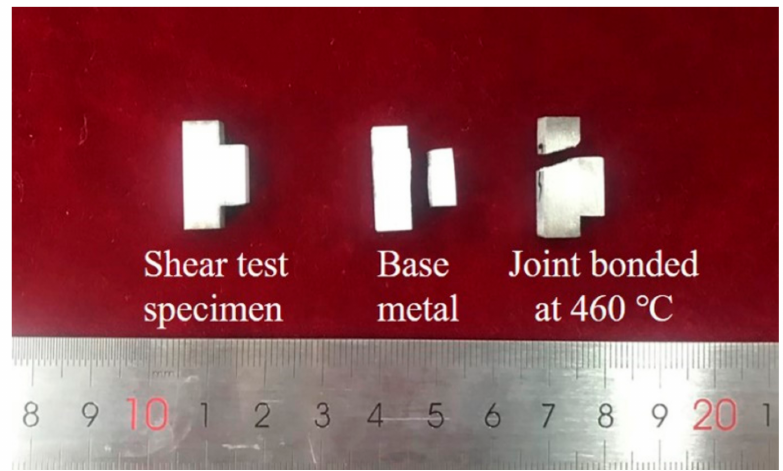
Figure 12. Image of the joint bonding at 440 ◦ C and the base metal after shear